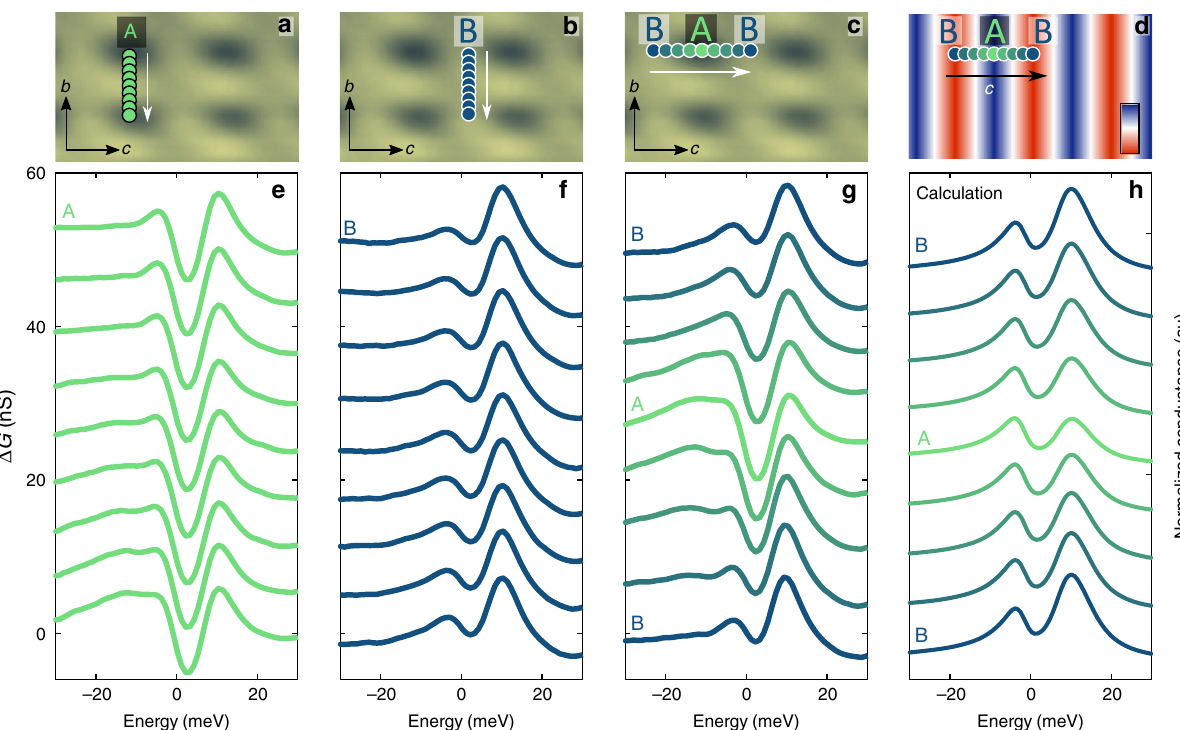
Fig. 2 Atomic scale variation of the fermion mass. a – c Topographic images with color-coded dots indicating the spatial positions where the STM tunneling spectra were acquired (with corresponding colors in e – g ; V bias = − 100 meV and I setpoint = 1.7 nA). In a , b the spectra were obtained along lines parallel to the b- axis that are one lattice constant long ( b = 4.6 Å). They display negligible spatial variation ( e , f ) and correspond to light (layer A) and heavy mass (layer B), respectively. c , g Tunneling spectra across a one lattice constant long ( c = 7.5 Å) line parallel to the c -axis between two consecutive B layers showing alternating peak – dip structure and indicating that the observed electron mass varies with the position in the unit cell. The same smooth background is subtracted from all spectra and the curves are vertically shifted for clarity. d The spatial dependence of the modeled tunneling sensitivity ratio ( t f /t c ), where t f and t c describes the sensitivity of tunneling into the heavy and light part of the excitations, respectively. Color scale shows the ratio from − 0.54 to − 0.3. h Calculated tunneling spectra along the c-